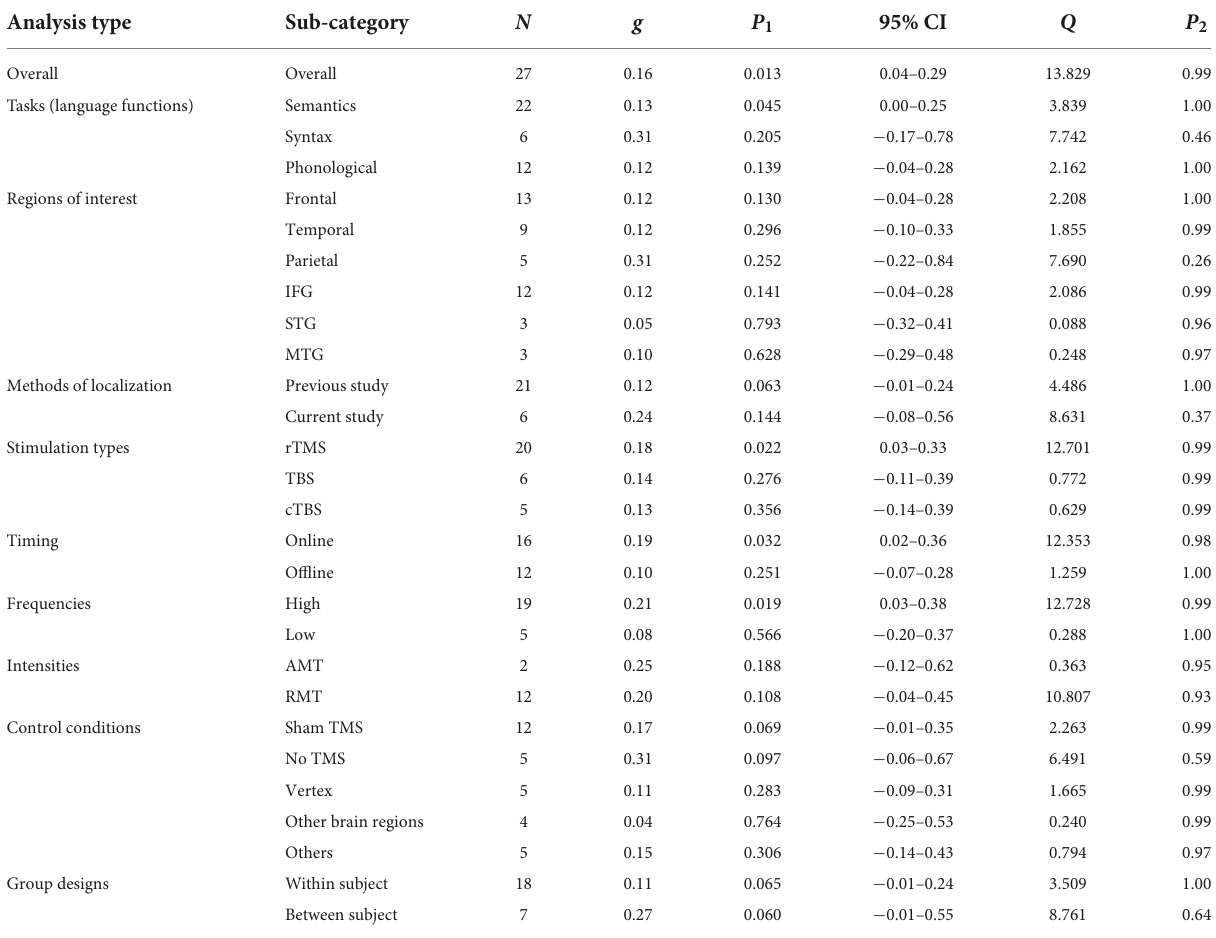
TABLE 3 Reaction time (RT) results of overall effect analyses and moderator